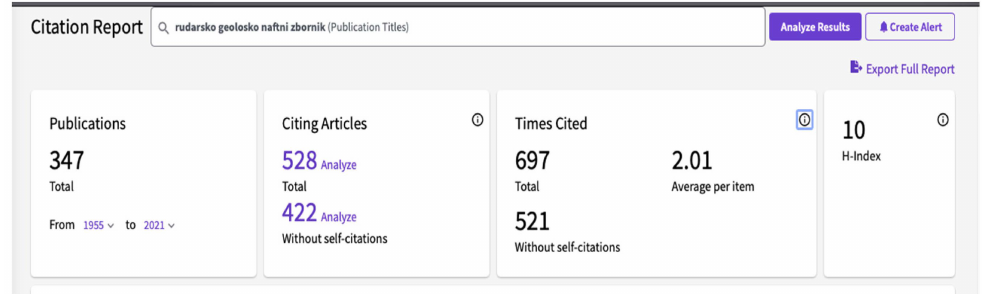
Figure 11. The number of papers and citations of the analysed journal in WoS, including h-index (October